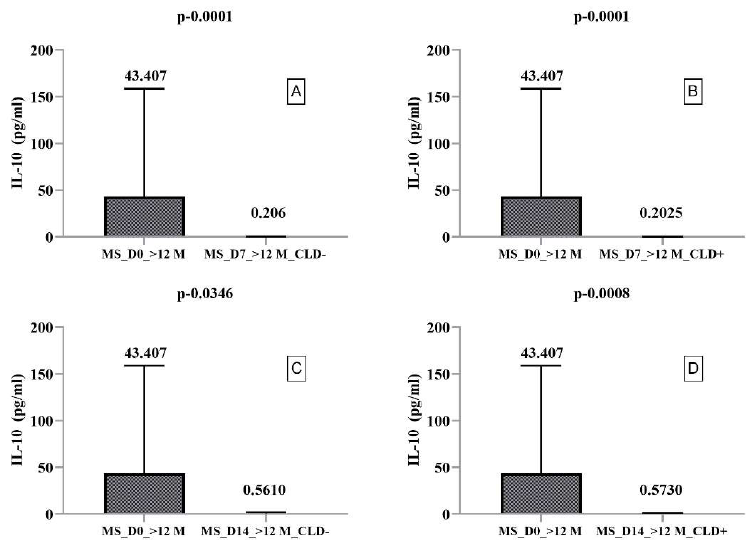
Figure 3. Boxplot type diagrams through which we followed the medians and interquartile range. Median values and statistical significance are mentioned in the graph. Comparison of CLD exposure effects on IL-10 secretion by PBMCs harvested from RRMS patients with a disease duration of >12 months on day 0 with days 7 and 14. ( A ) Comparison between the level of IL-10 secreted by PBMC ex vivo and on day 7 of the study in the absence of exposure to CLD; ( B ) Comparison between the level of IL-10 secreted by PBMC ex vivo and 7 days after exposure to CLD; ( C ) Comparison between the level of IL-10 secreted by PBMC ex vivo and on day 14 of the study in the absence of exposure to CLD; ( D ) Comparison between the level of IL-10 secreted by PBMC ex vivo and 14 days after exposure to CLD.